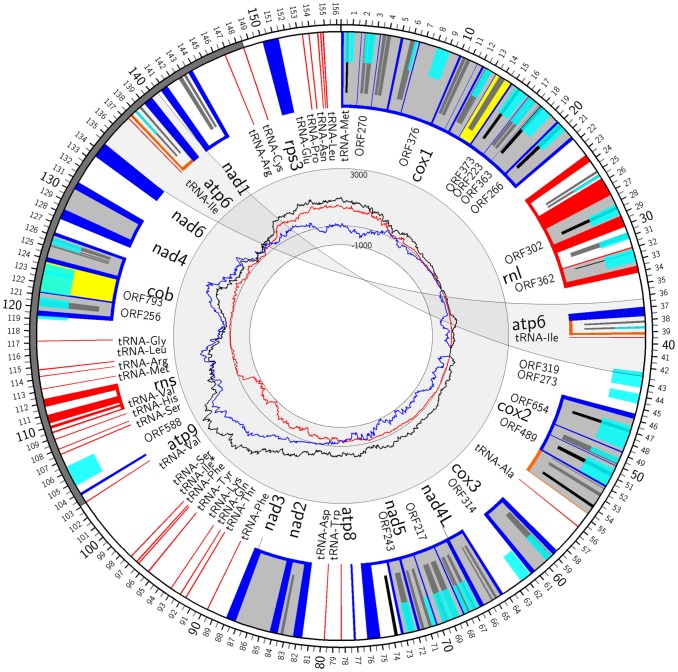
Gene map of Phlebia radiata mtDNA.Colour of the scale (kb) bar indicates orientation of transcription: clockwise (CW, white), counter-clockwise (CCW, grey). Bars mark protein-coding (blue) and RNA (red) genes, and alternative C-termini in atp6 and cox2 are depicted (orange). Intron type is indicated in colour: group I (light grey), group II (yellow), and uncertain (white). Within introns, the hypothetical and identified ORFs are indicated: over >200 amino-acid long ORFs (turquoise), and homing endonuclease domains GIY-YIG (black) and LAGLIDADG (dark grey). The transparent ribbon illustrates location of the 6,076 bp inversion-duplication. Asterisk indicates putative tRNA-IleCAU. The inner circle (scale at 12 o’clock in linear units) plots nucleotide bias (G/C skew) up to hexamers along each mtDNA position; G/C (red), A/T (blue), total strand bias (black), placing oriC around 11∶30 o’clock as the largest bias of G over C.